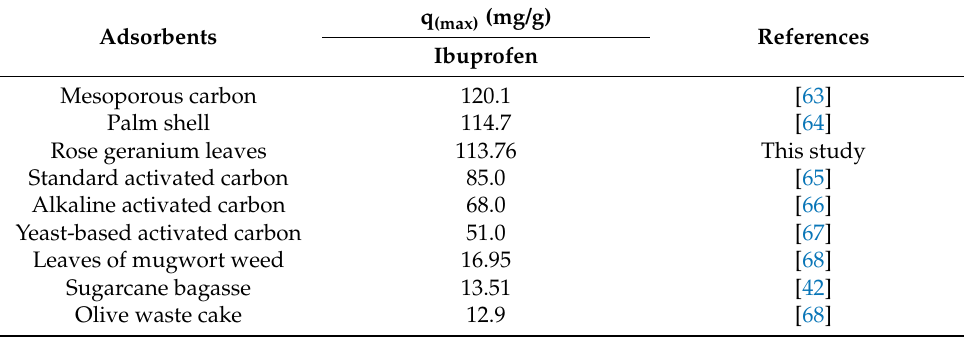
Table 7. Uptake of ibuprofen using activated carbon-based adsorbents.